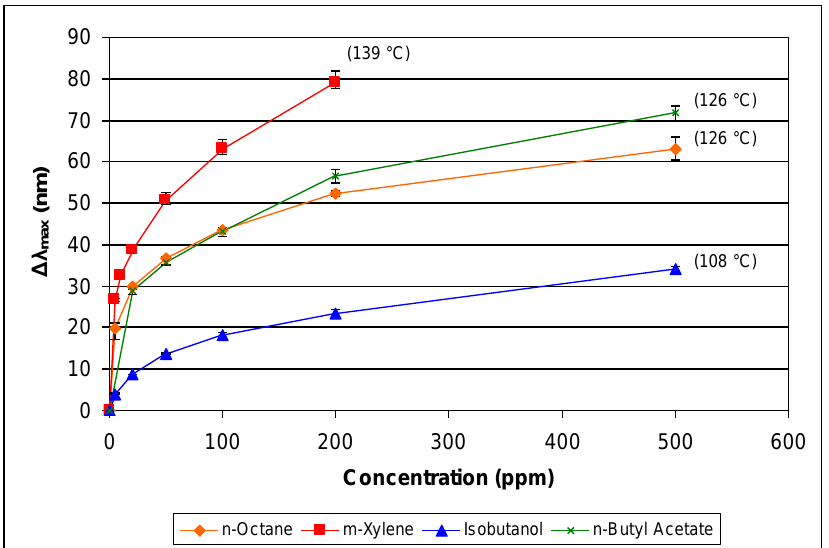
Figure 11. Comparative responses of sensor to organic analytes with similar vapor pressures but different boiling points (noted in parentheses) at various